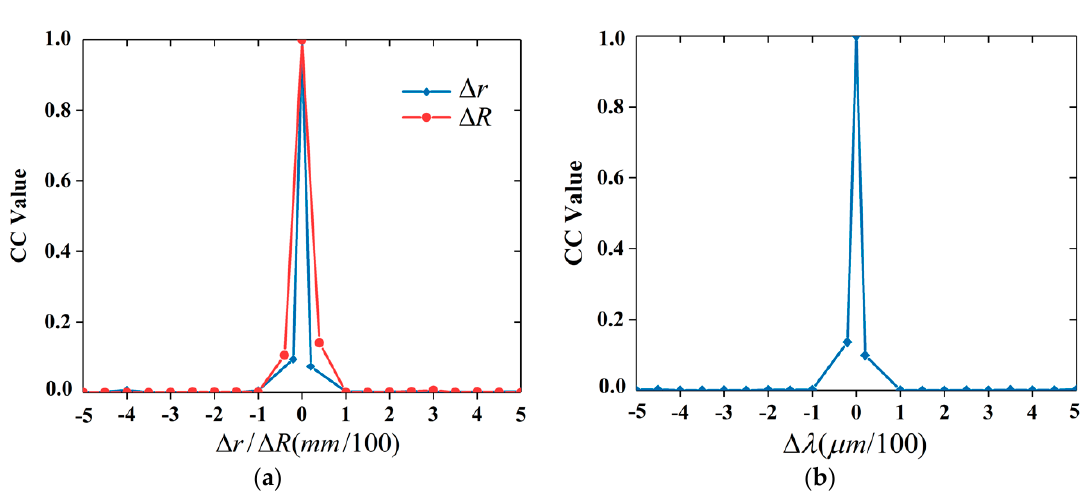
Figure 6. Correlation coefficient (CC) values of decrypted images with incorrect keys: ( a ) Δ r / Δ R (mm/100), ( b ) Δλ ( μ m/100).